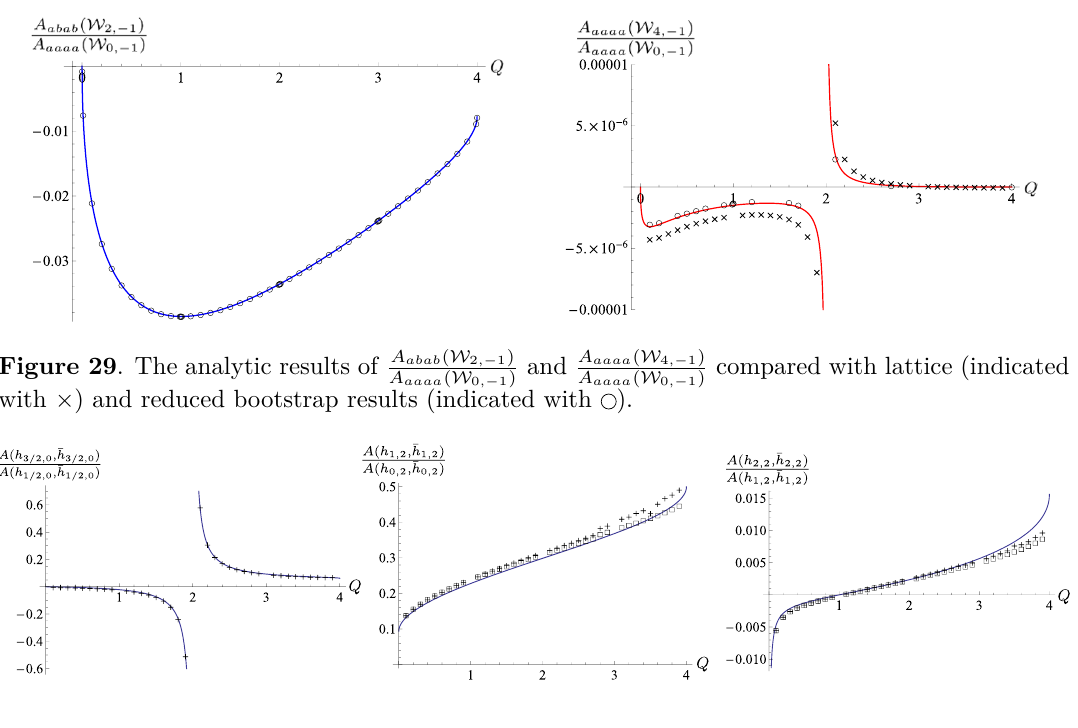
Figure 30 . The recursions (4.5) compared with lattice results. The continuous curves are the analytic expressions. The “ + ” indicate the lattice results from the amplitudes in P aaaa and “ (cid:3) ” indicate the lattice results from P abab + P abba